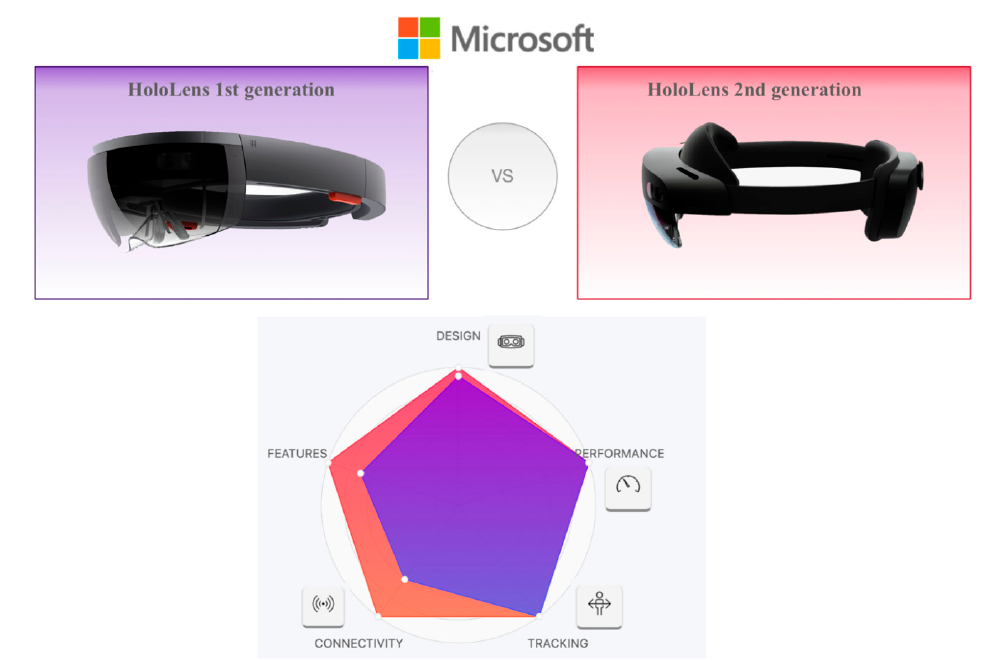
Figure 2. HoloLens’ first- and second-generation comparison. Table 3. HoloLens 2 specifications compared to the first-generation HoloLens. HoloLens 2 HoloLens 1